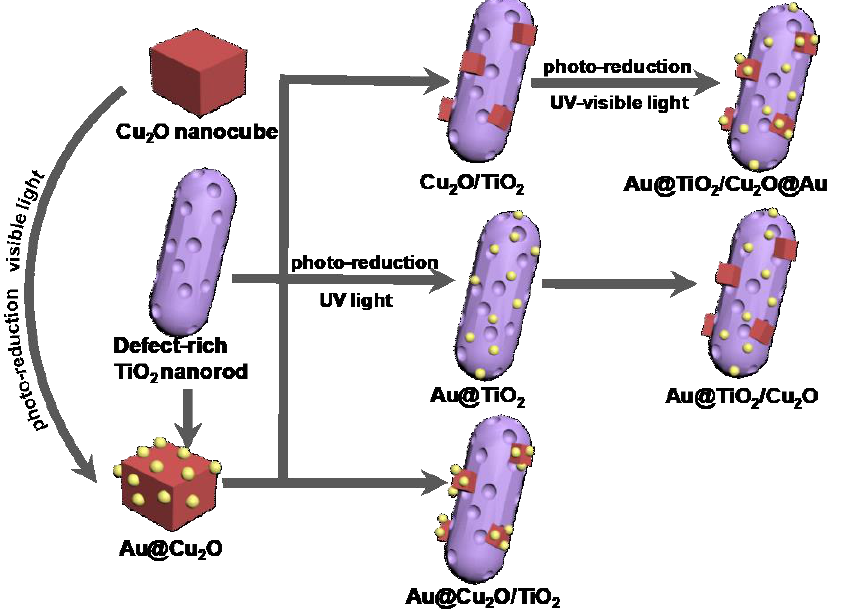
Scheme 1. The procedure for catalyst preparation by site-specific deposition of Au on the support.